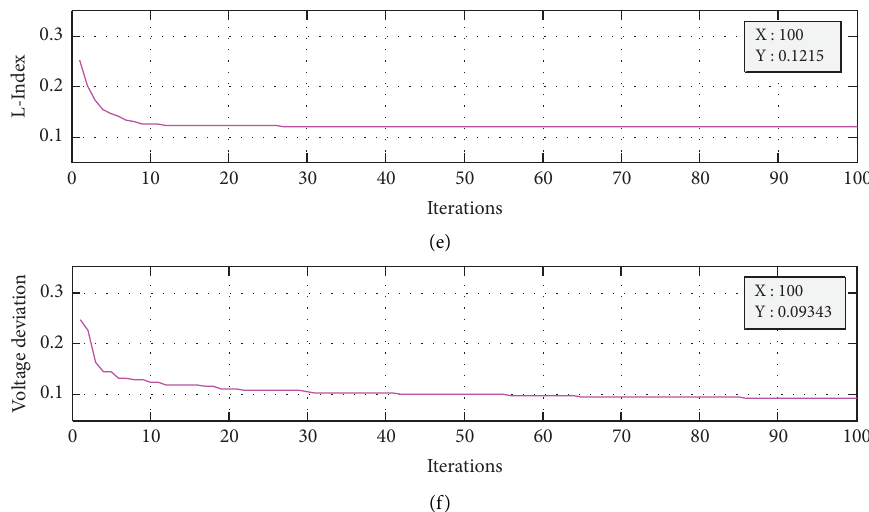
Figure 5: Convergence characteristic curves for single-objective OPF (case 1 through case 6) of the IEEE 30-bus system: (a) Case 1; (b) Case 2; (c) Case 3; (d) Case 4; (e) Case 5; (f) Case